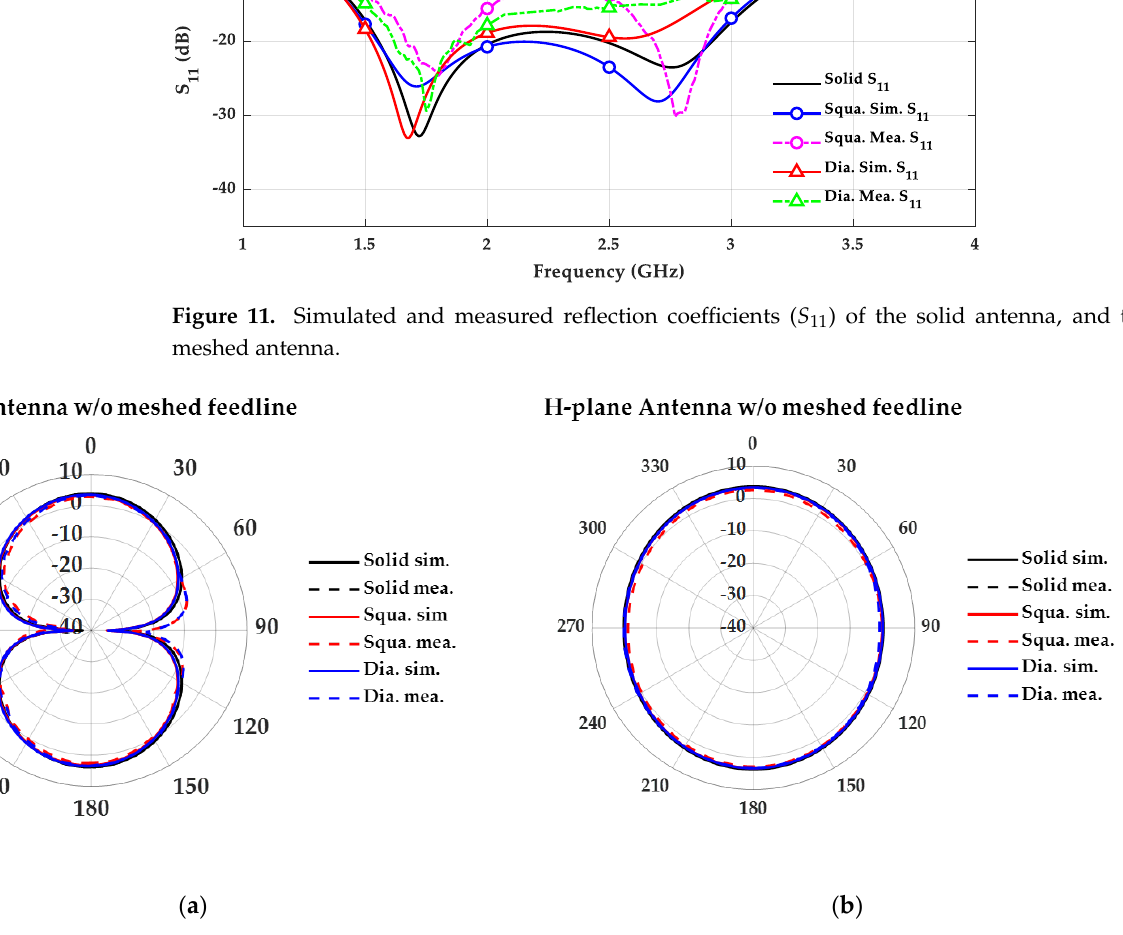
Figure 12. Simulated and measured 2-d radiation pattern of antennas without meshed feedline: ( a ) E-plane; ( b ) H-plane.